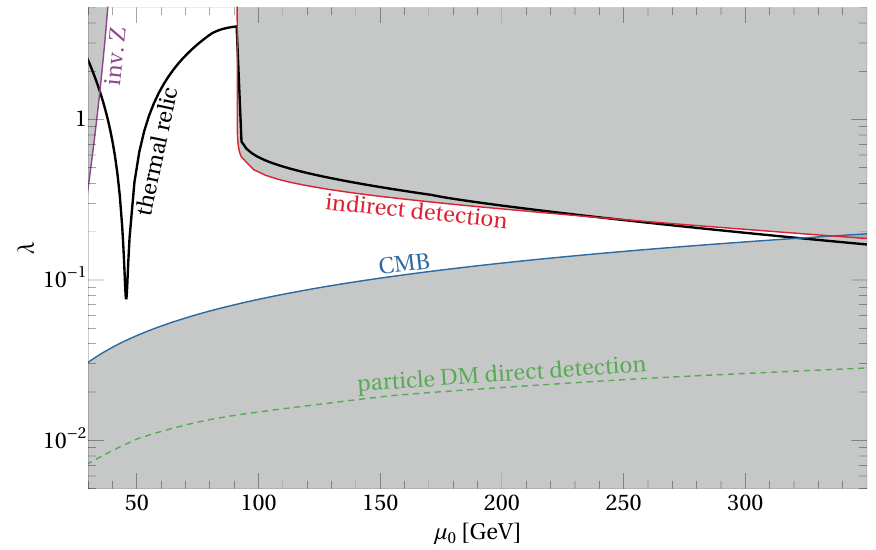
Figure 3 . Parameter space for continuum vector Z -portal DM. The black curve reproduces the observed thermal relic density [37]. We show experimental constraints from CMB observations (blue) [38, 39], indirect detection with the Fermi-LAT experiment (red) [40, 41], and the LEP bound on the invisible Z width (purple) [43]. We also show the LUX-ZEPLIN direct detection bound for ordinary particle vector Z -portal DM (green, dashed)